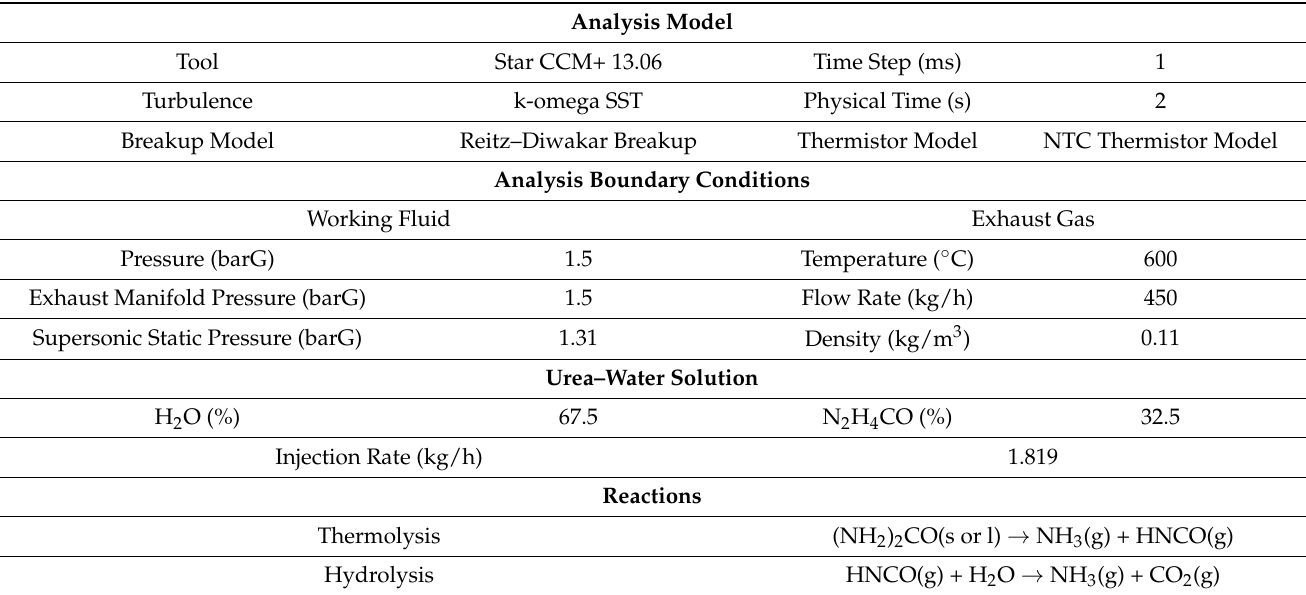
Table 2. Conditions for the numerical analysis.